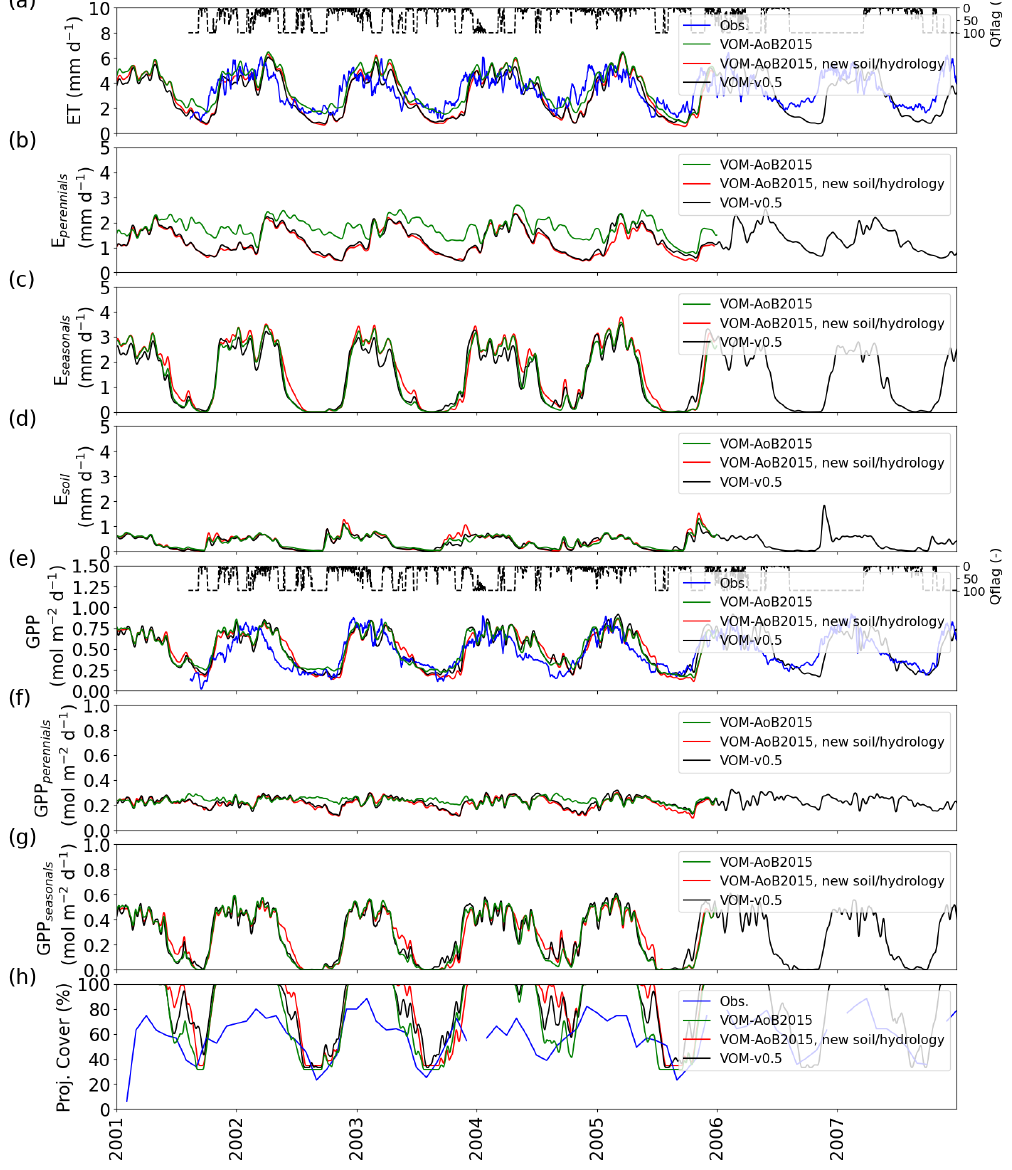
Figure 5. Comparison between the results of the VOM-AoB2015 in green, simulations using new soil and hydrological parameterization (red) and simulations using all changes in combination (black). (a) ET, (b) transpiration by perennials (trees), (c) transpiration seasonals (grasses), (d) soil evaporation, (e) GPP, (f) GPP perennials (trees), (g) GPP seasonals (grasses) and (h) projective cover. Time series in (a) – (g) were smoothed using a moving average of 7d. The daily average quality flags of the flux tower observations are shown as a dashed line in panel (e) , with a value of 100 for a completely gap-filled day and 1 for gap-free